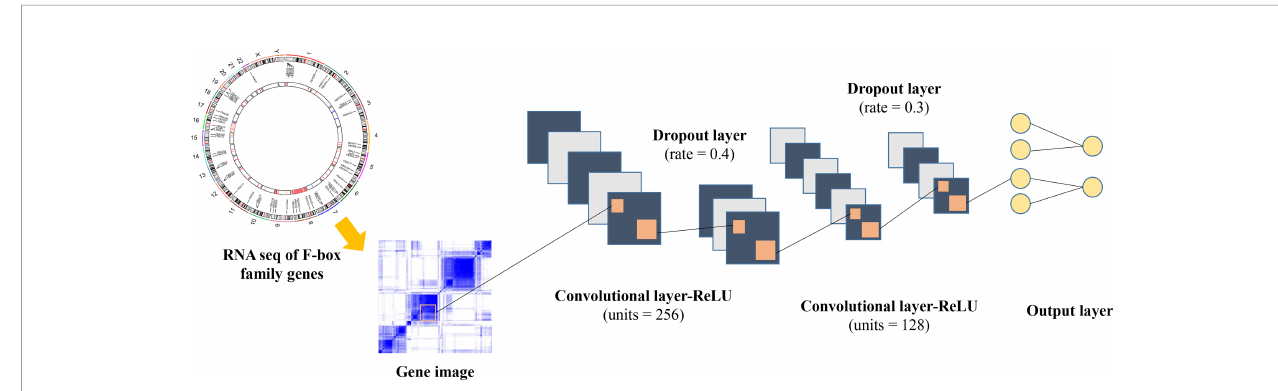
FIGURE 1 | Framework of the deep neural network in this